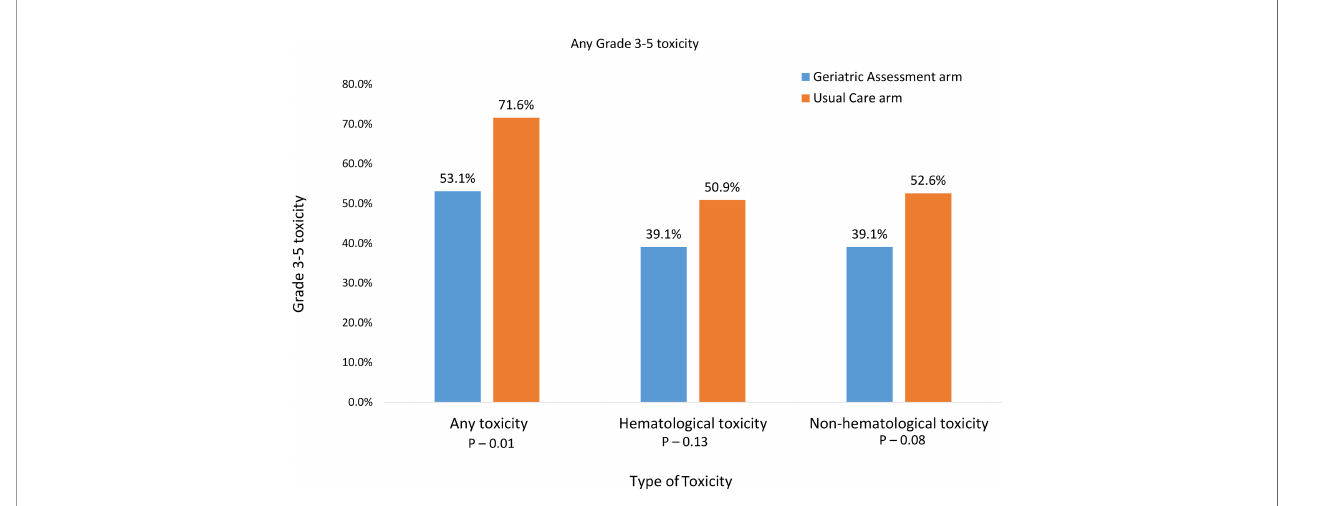
FIGURE 1 | Prevalence of grade 3-5 toxicities over 3 months after the start of new treatment for advanced stage III/IV lung